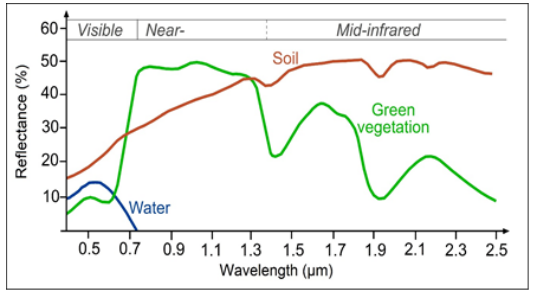
Figure 1. The spectral signatures of different LU/LC types through the electromagnetic spectrum.